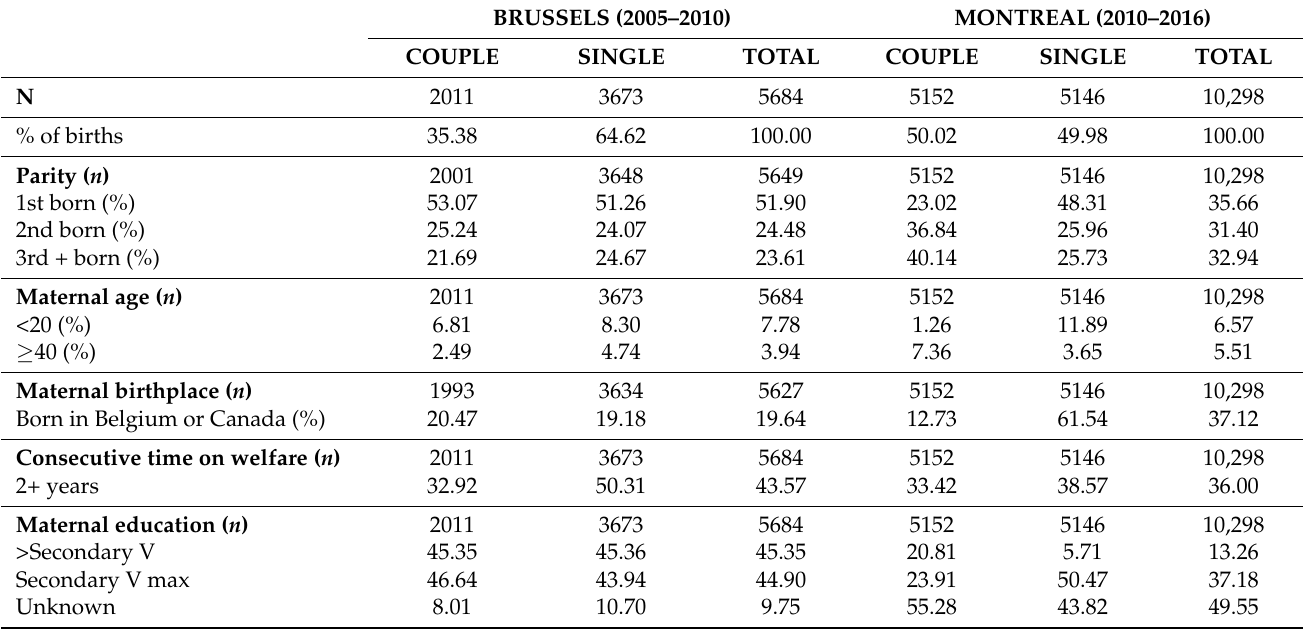
Table 4. Socio-demographic characteristics of mothers on welfare.